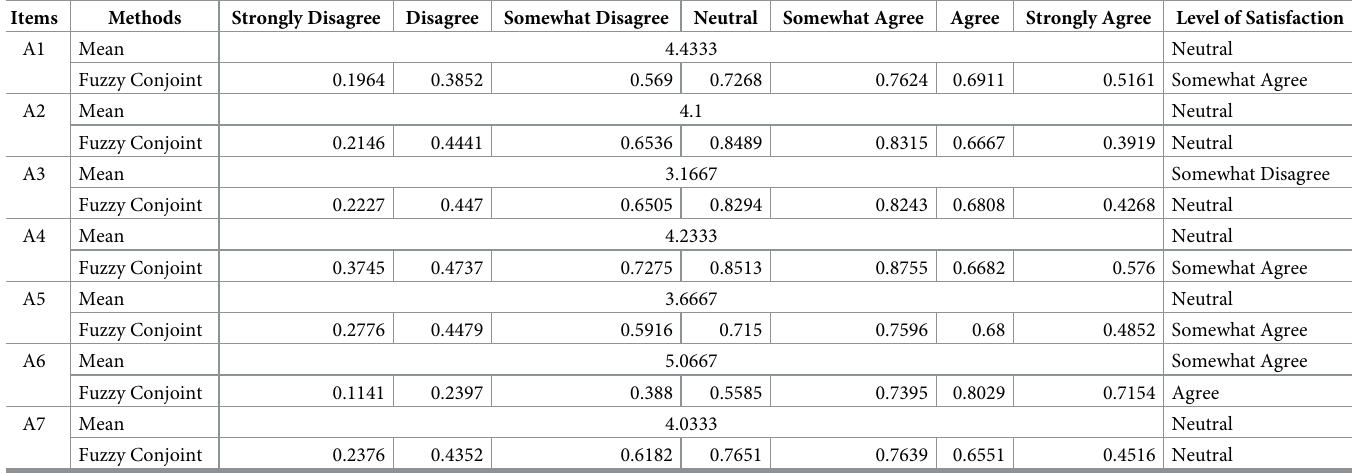
Table 5. Comparison of methods used to evaluate the levels of customer satisfaction on the cleanliness of food premises.